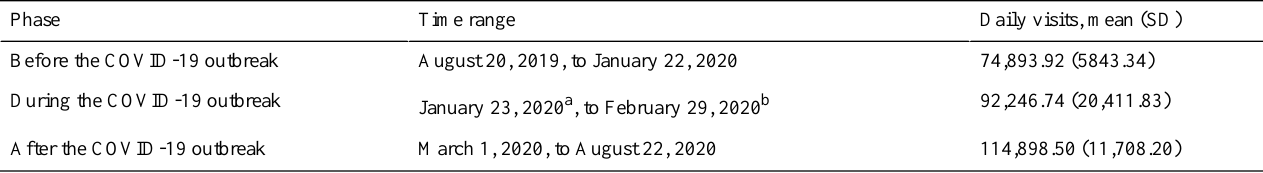
Table 4. Average daily visits to Ping An Good Doctor before, during, and after the outbreak of COVID-19 in China.